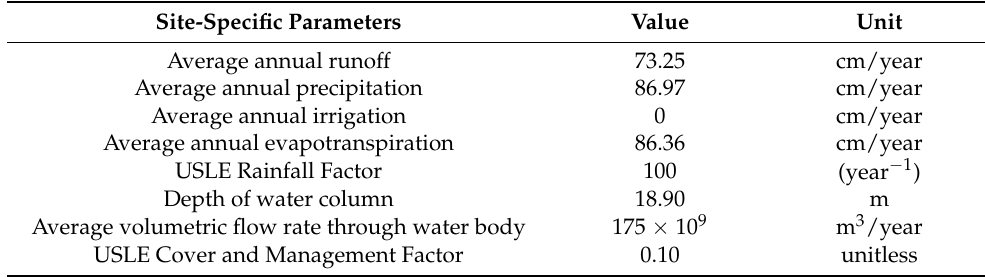
Table 5. Site-specific data used in IRAP-h View